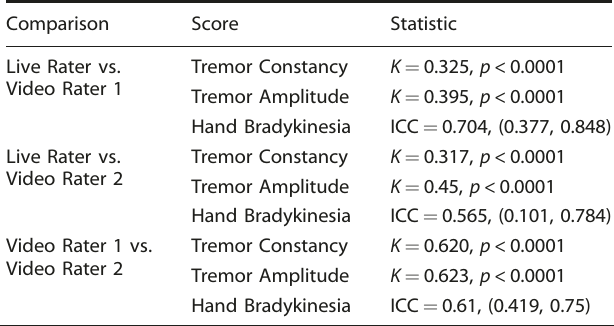
Table 1. Comparison of video raters and live rater for tremor and hand bradykinesia MDS-UPDRS scores. Comparison